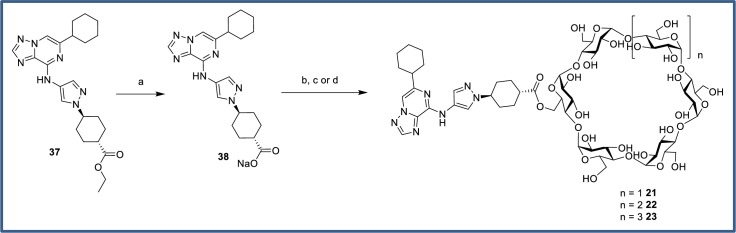
Synthesis of carboxylate-linked cyclodextrin prodrugs.Reagents and conditions: (a) NaOH, MeCN/H2O, quant; (b) Mono-6-O-(p-toluenesulfonyl)-α-cyclodextrin, DMA, 100°C, 33%; (c) Mono-6-O-(p-toluenesulfonyl)-β-cyclodextrin, DMA, 100°C, 23%; (d) Mono-6-O-mesitylenesulfonyl-γ-cyclodextrin, DMA, 100°C, 27%.